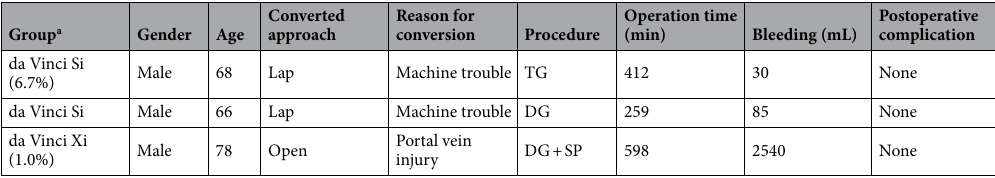
Table 2. Converted cases. Lap laparoscopic surgery; Open open surgery; TG total gastrectomy; DG distal gastrectomy; DG + SP distal gastrectomy with en-mass removal of the spleen and body and tail of the pancreas. a P = 0.125.